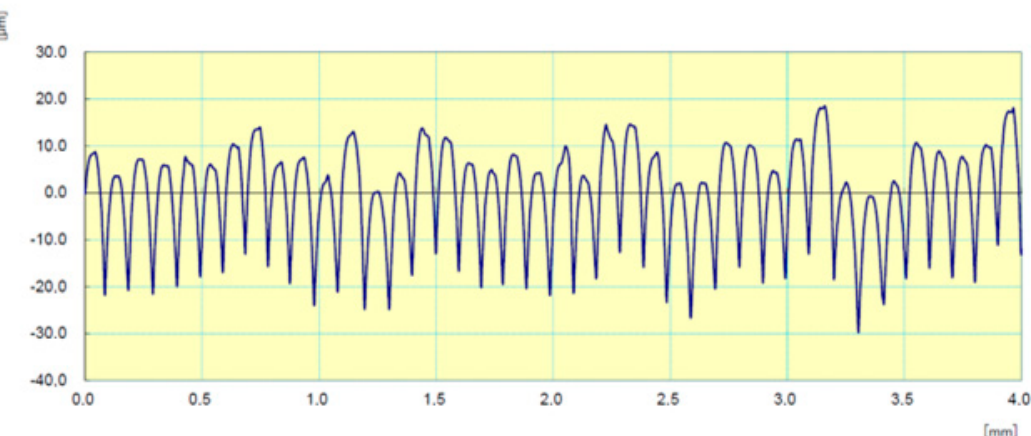
Figure 20. The measured surface on the sample with the 0.1 mm layer height.